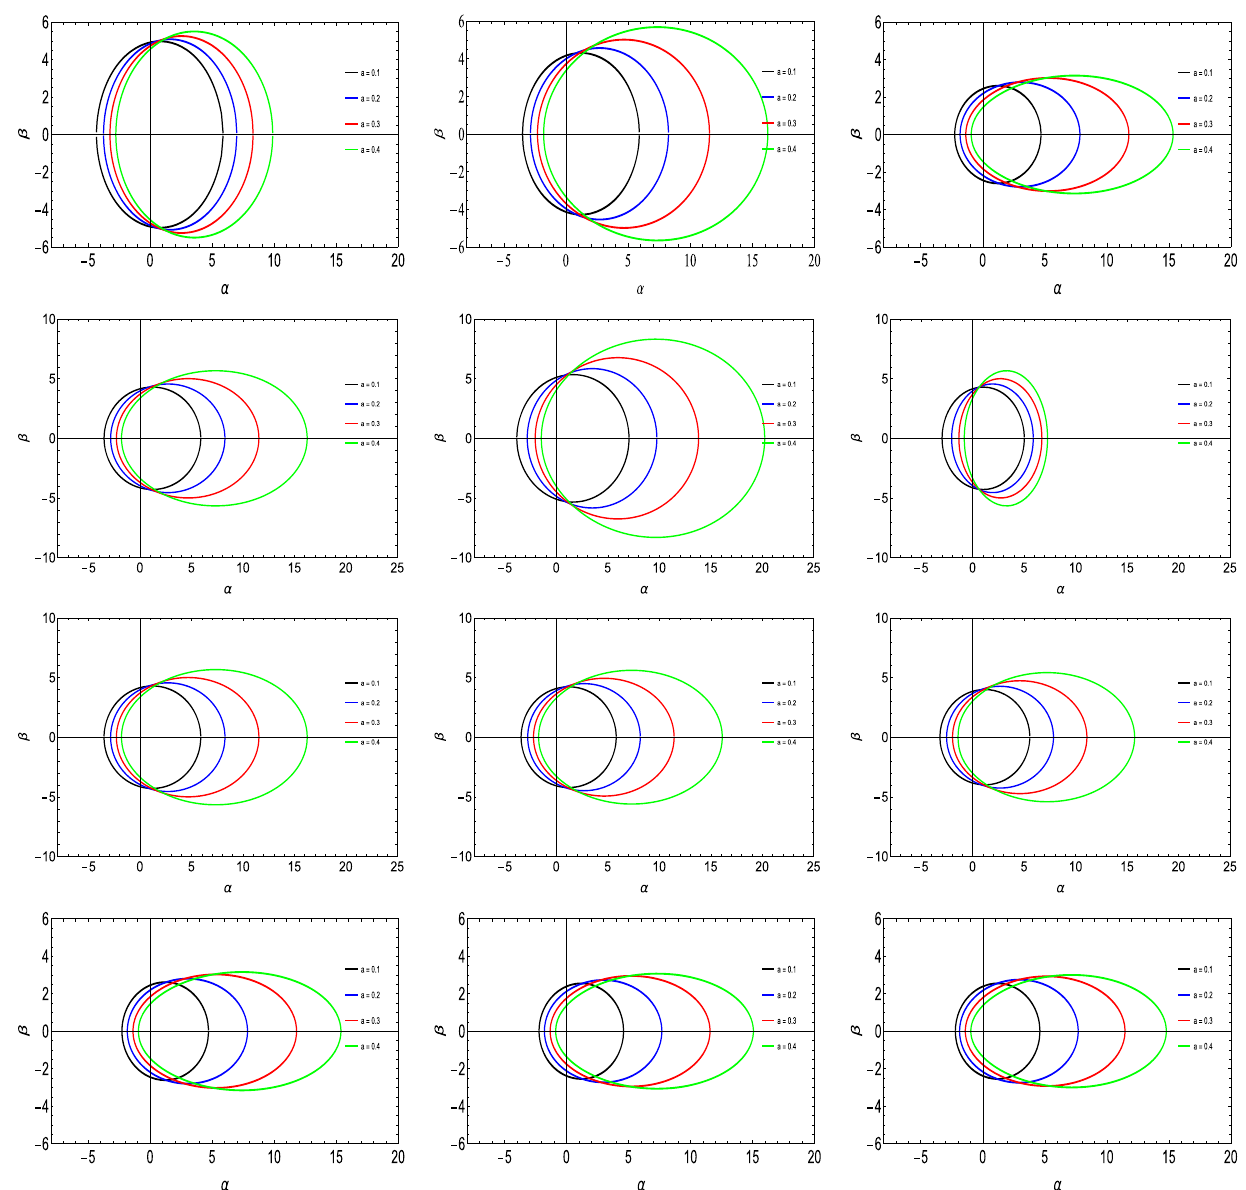
Fig. 3 The variation in photon rings for different values spin parameter ‘a’ with different values of gauge coupling constant g (top panel), NUT charge N g (second panel), electric charge e (third panel) and magnetic charge ν (bottom panel) for M = 1